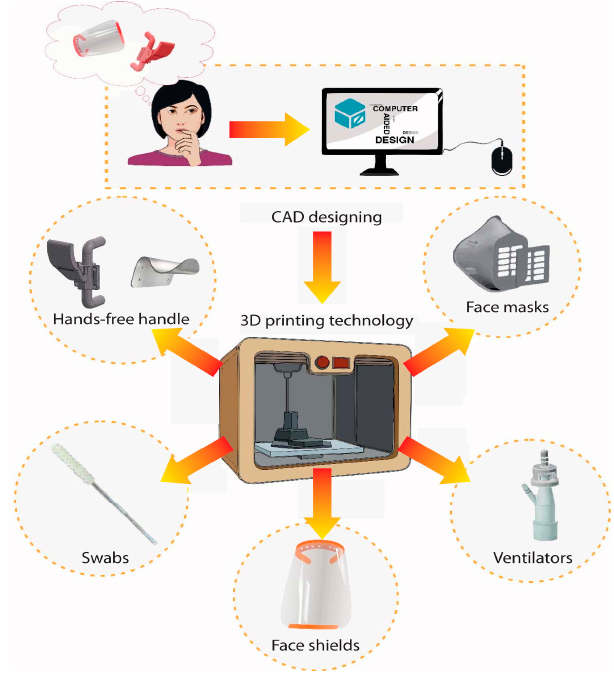
Figure 12. An example of the 3D printing process from conceptualization through computer-aided design modeling and manufacture of several pieces used in the COVID-19 pandemic defense. Figure reproduced from [149].